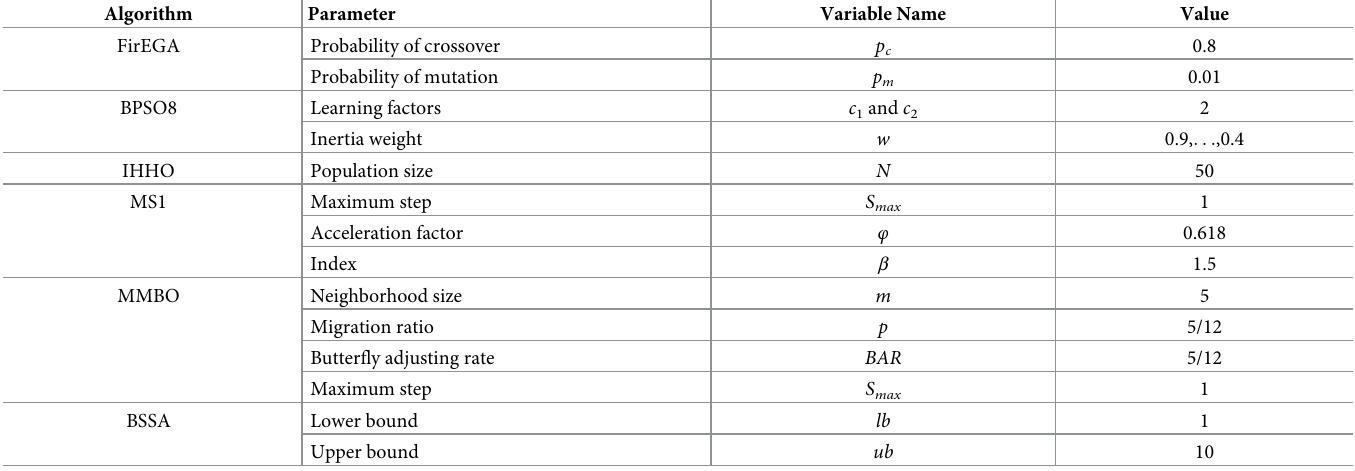
Table 2. Simulation